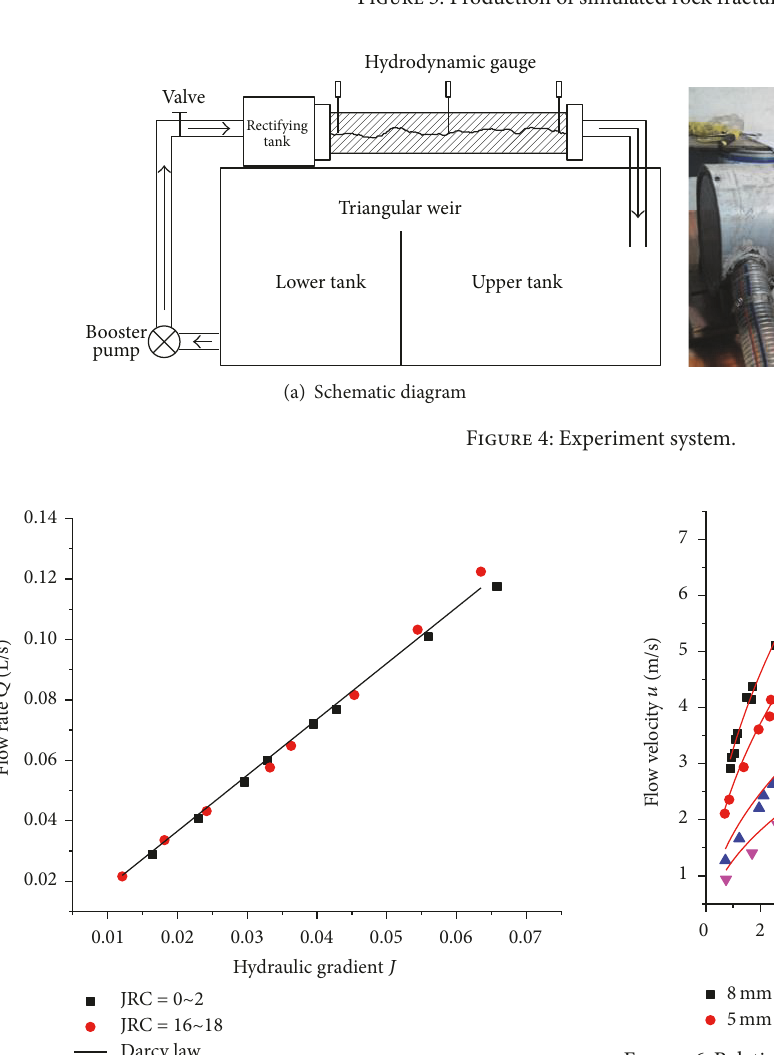
Figure 3: Production of simulated rock fracture mold.